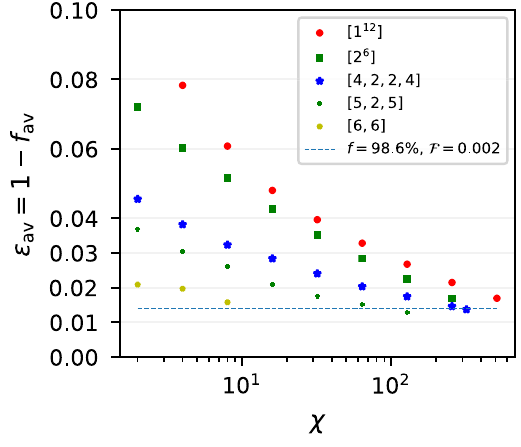
1 − f as a function of av ¼ av